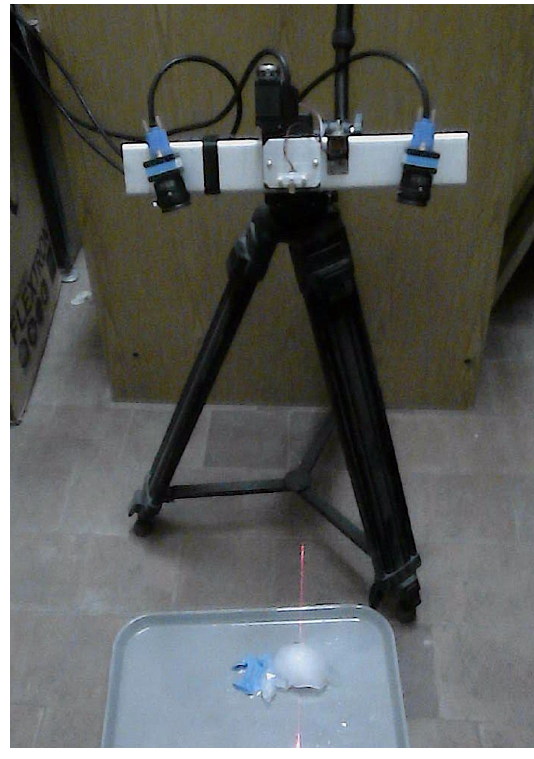
Figure 4. Visible range setup